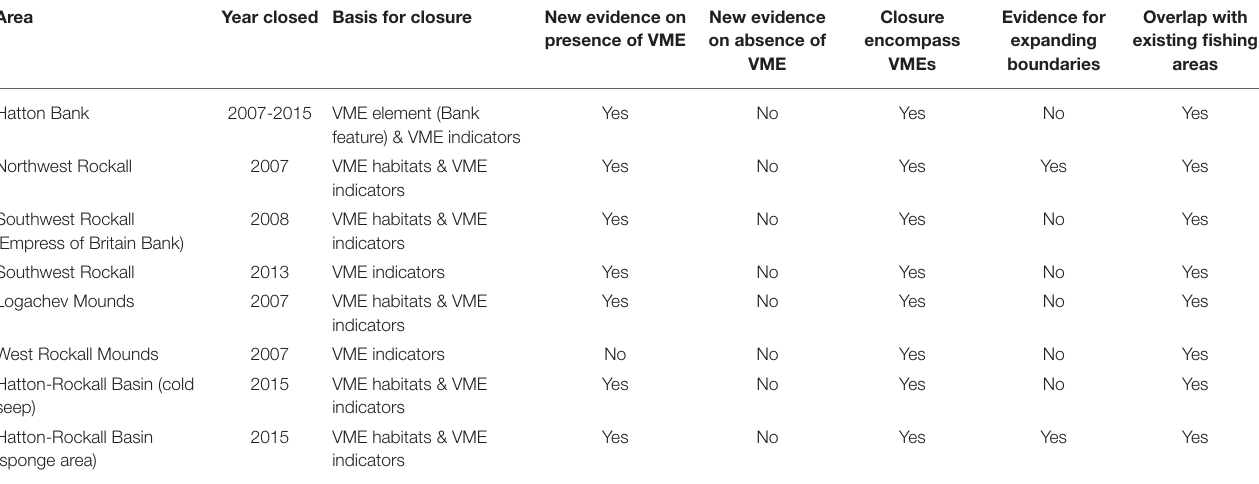
TABLE 1 | Summary of the review of NEAFC VME closures (NEAFC, 2017).